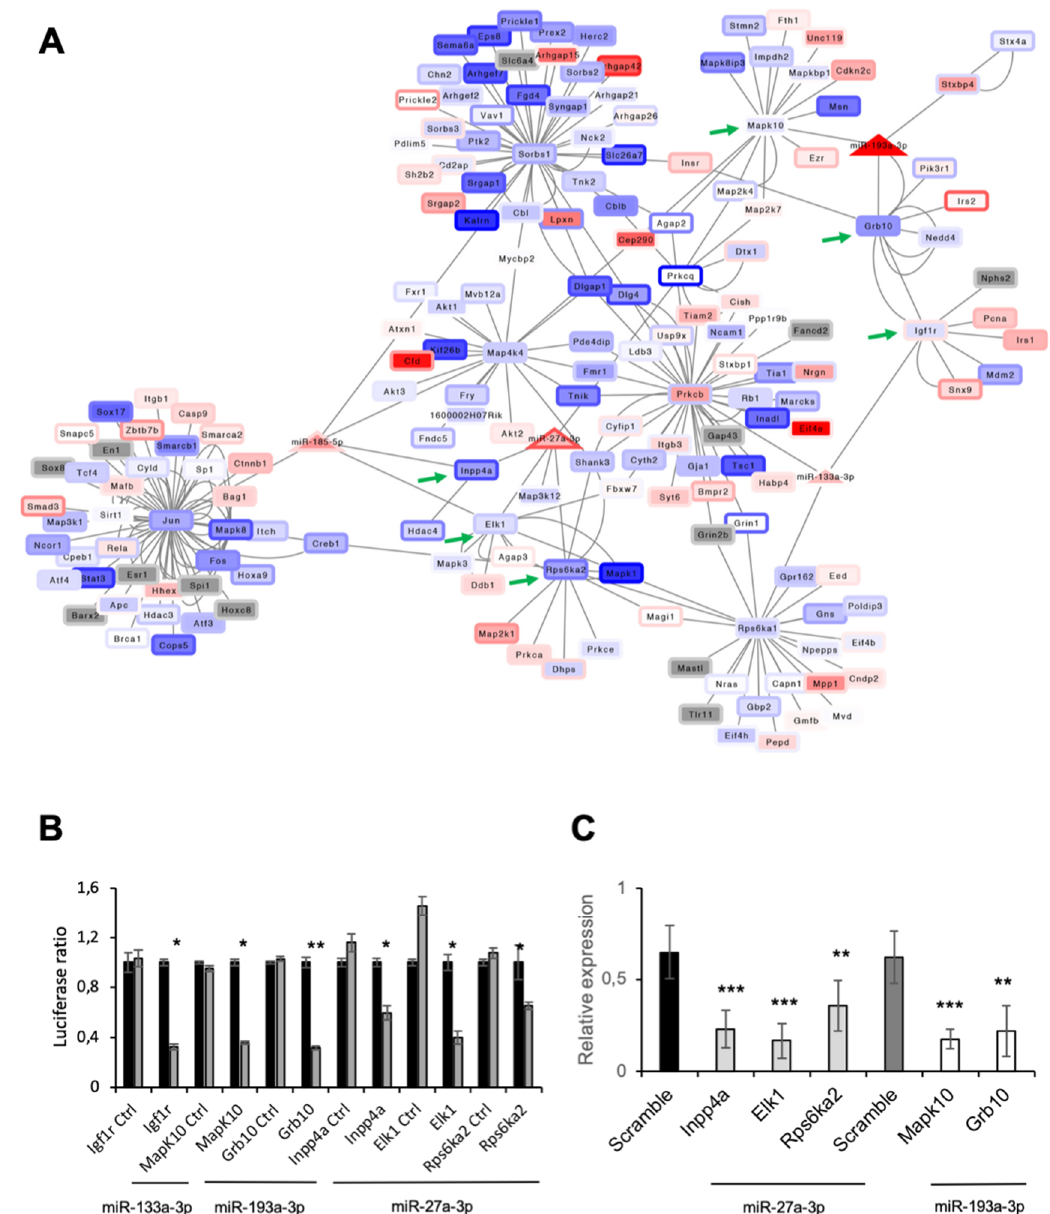
Figure 6. Interaction of miRNAs with their targets. ( A ) Network representing the interaction between miRNA (triangles) and targets (rectangles). Interactions among rectangles represent interactions retrieved from the BioGrid database. Colors inside nodes represent gene expression calculated as D/D + P, while border colors represent gene expression calculated as D/C. Green arrows indicate target miRNAs for which we validated miRNA–gene interactions. ( B ) Luciferase assay was performed to demonstrate the direct interaction between miR-133a-3p and Igf1r ; miR-27a-3p and Inpp4a , Elk1 and Rps6ka2 ; miR-193a-3p and Mapk10 and Grb10 . Part of Igf1r , Inpp4a , Elk1 , Rps6ka2 , Mapk10 and Grb10 sequences containing putative miRNA interaction sites (or not containing; Igf1r-, Inpp4a-, Elk1-, Rps6ka2-, Mapk10-, Grb10-Ctrl) were cloned into pmirGLO vector. Firefly luciferase (reporter gene) and Renilla luciferase (control reporter for normalization) activities were measured after transfection of cardiomyocytes together with miRNA mimics or a scramble sequence (Ctrl). ( C ) Gene expression of miR-27a-3p and -193a-3p targets after specific miRNA or scramble overexpression in cardiomyocytes. For both panels, data are expressed as the mean of at least four independent transfections. Significance was calculated using t -test between samples considering unequal variance between samples. * p ≤ 0.05; ** p ≤ 0.002; *** p ≤